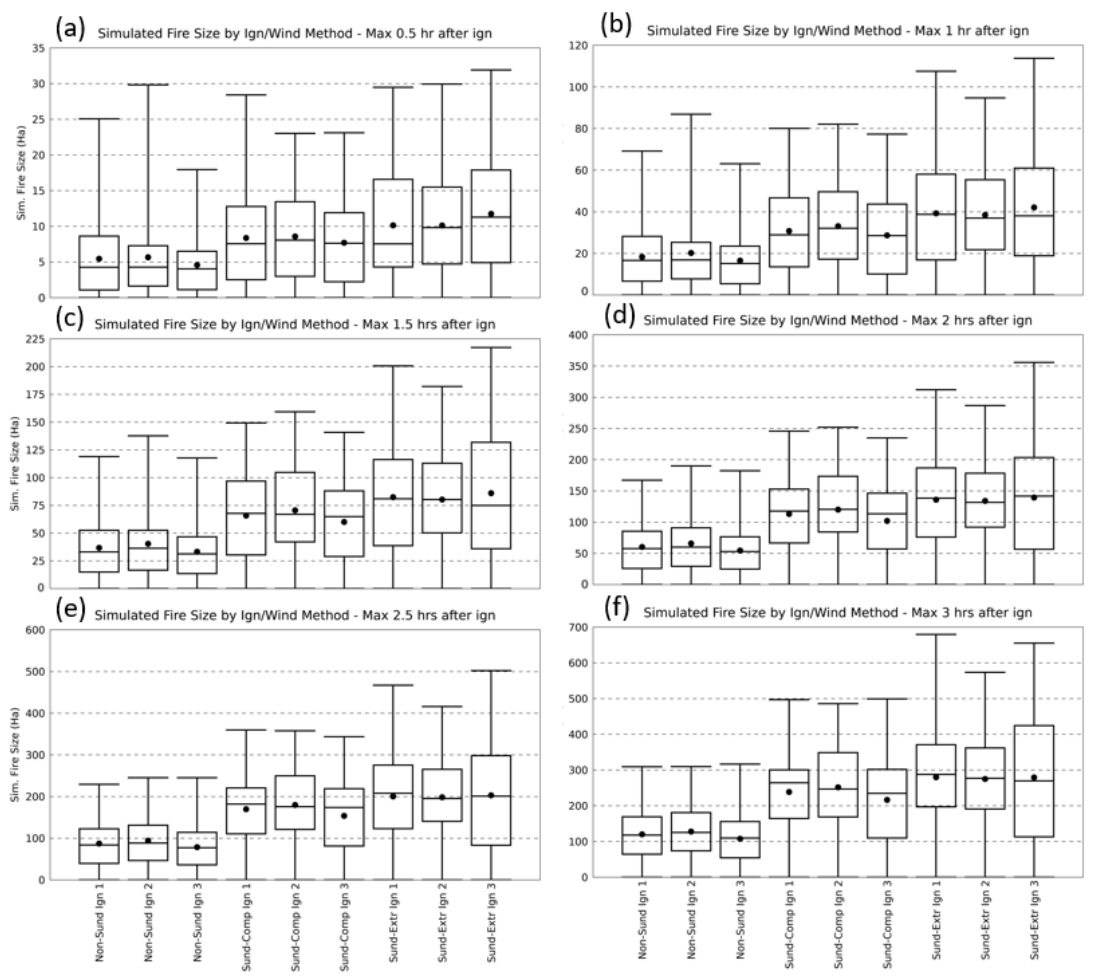
Figure 7. Boxplots showing the distribution of wildfire sizes for each ignition method and wind scenario combination every half hour. The whiskers identify the minimum and maximum values, and the box includes the lower quartile, median, and upper quartile. No outliers were identified, and the dot indicates the mean. Note the different y -axis values on each histogram.